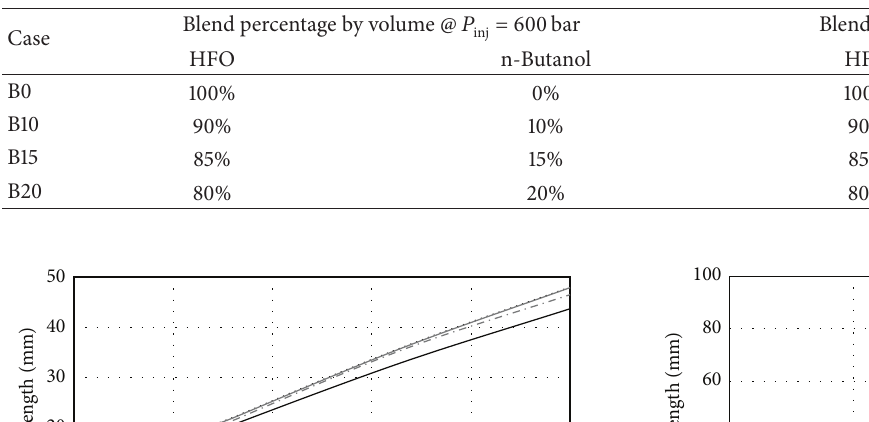
Table 5: Properties of tested fuel blends.